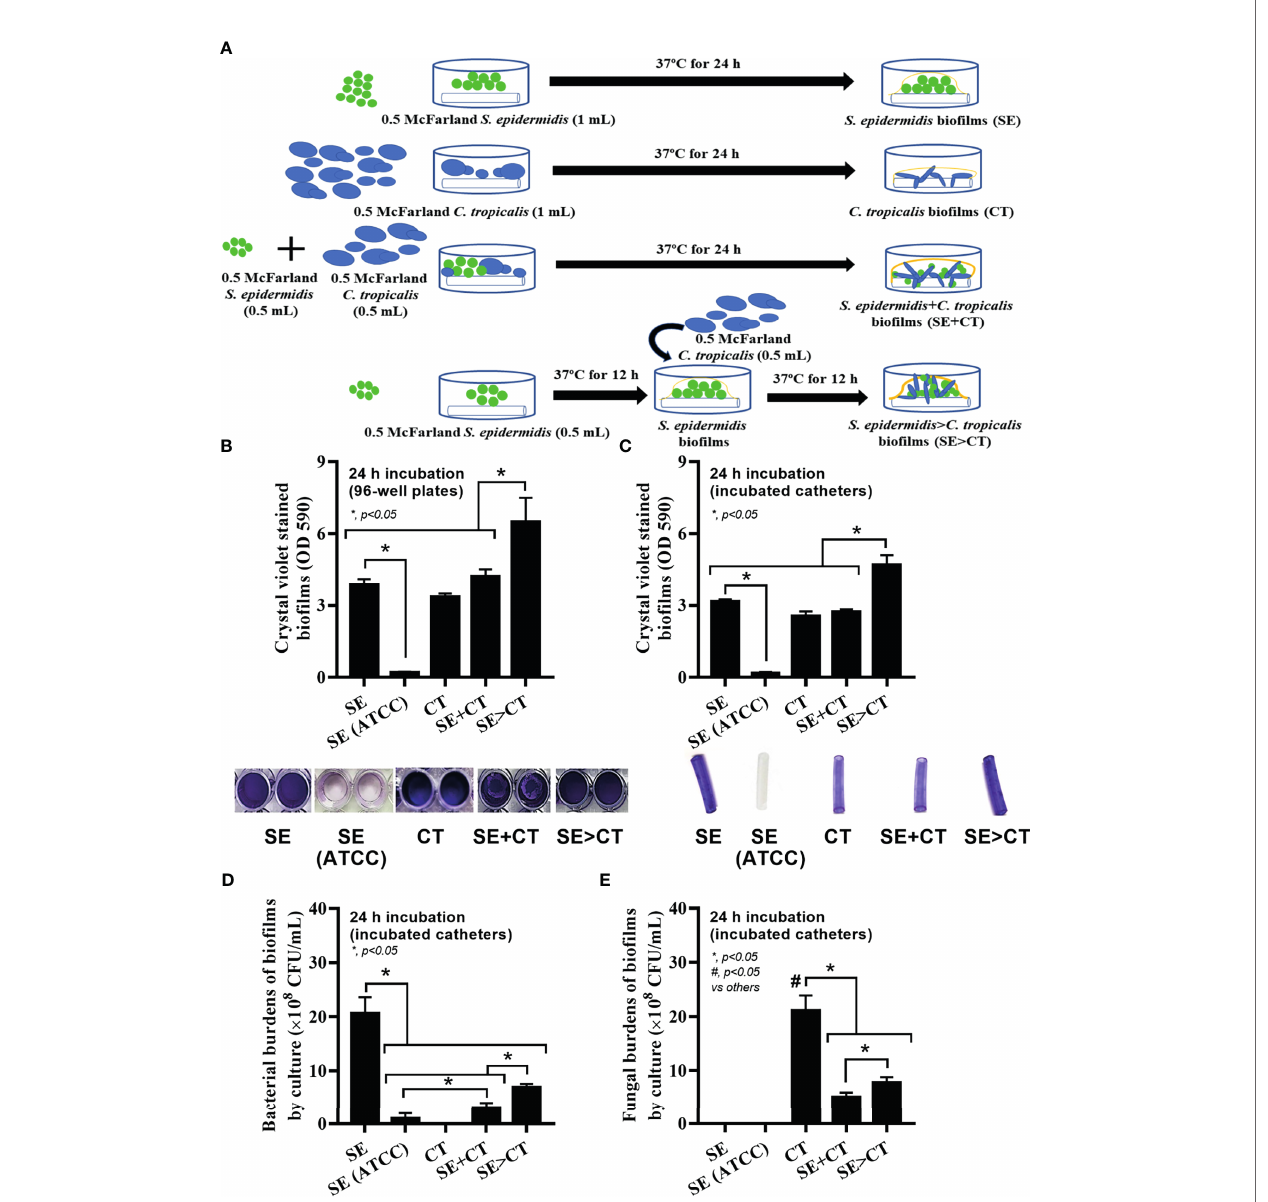
FIGURE 1 | Schema of the in vitro experiments for the preparation of bio fi lms from Staphylococcus epidermidis (SE), Candida tropicalis (CT), SE simultaneously mixed with CT (SE + CT), and preformed SE bio fi lms following CT (SE > CT) (A) are demonstrated. Characteristics of bio fi lms from SE, either the clinically isolated strain (SE) or the standard strain [SE (ATCC)], CT, SE + CT, and SE > CT as determined by intensity of crystal violet color on 96-well plates and incubated catheters with the representative pictures (B, C) ; bacterial and fungal burdens on catheter bio fi lms (D, E) are demonstrated (independent triplicate experiments were performed). The results were from three independent experiments in triplicate as the mean ± SEM; p < 0.05 was considered statistically signi fi cant. *p < 0.05 was considered statistically signi fi cant in the same group whereas #p < 0.05 was those in the other